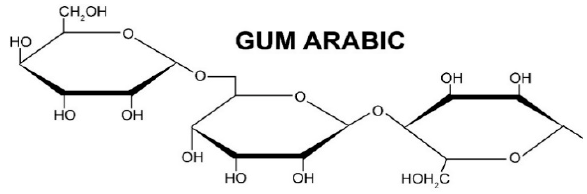
Figure 4. Molecular structure of gum arabic [74].